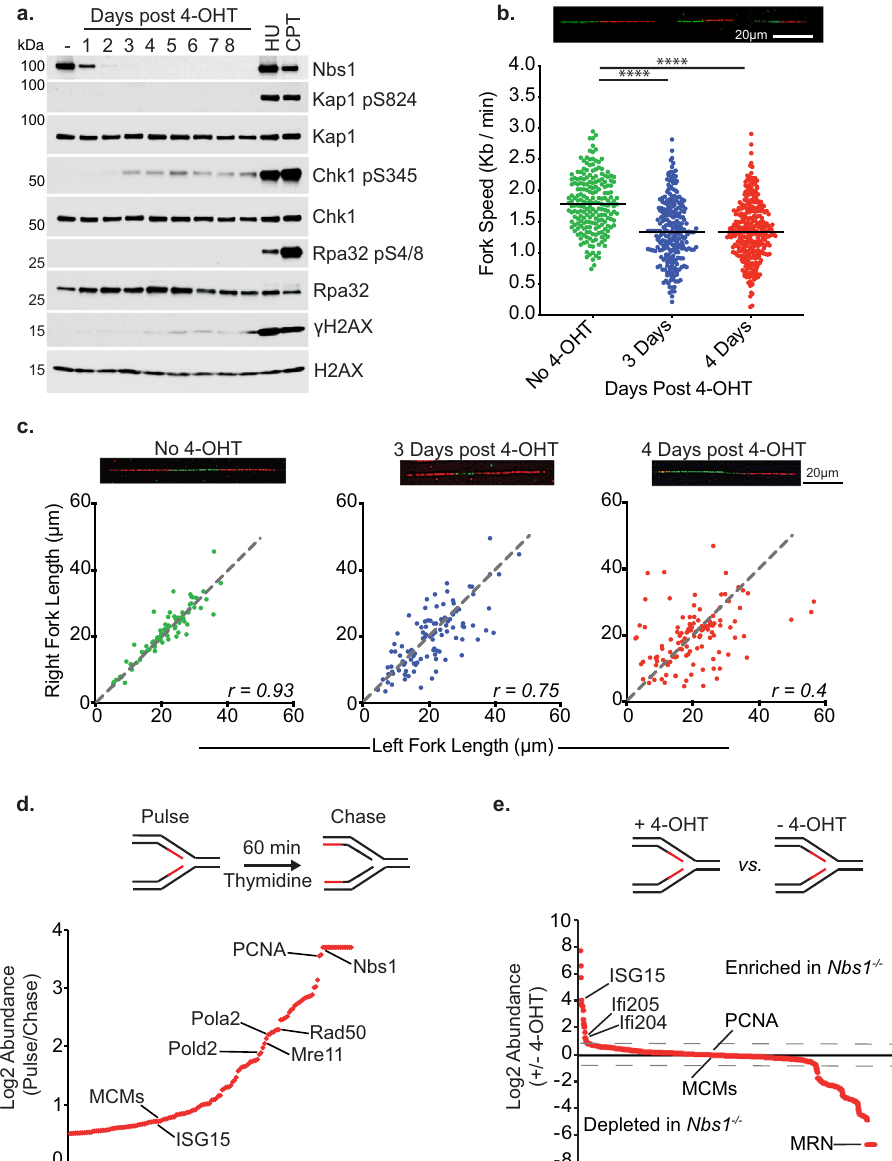
Fig. 1 | Deletion of Nbs1 Impacts DNA Replication. a Nbs1 f/f MEFs treated with 4-OHT for 48h. Whole cell extracts were taken at the indicated time points post 4-OHT addition for western blotting. Extracts from 2mM HU and 2 μ M CPT (2h) treatedcellsserved ascontrols forantibodyspeci fi city. b DNAcombing analysisof Nbs1 f/f at the indicated timepoints post 4-OHT addition. IdU=green fi ber, CldU= Red fi ber. CldU fi ber length was measured, and fork speed calculated. Combined datafromthreeindependentexperiments(No4-OHT n =207,3days n =250,4days n =329). Median velocity shown. Two Tailed Mann – Whitney test ****= p <0.0001. c Asinb.exceptLeft-RightratiosofCldU fi bersinitiatingfromthesameoriginwere